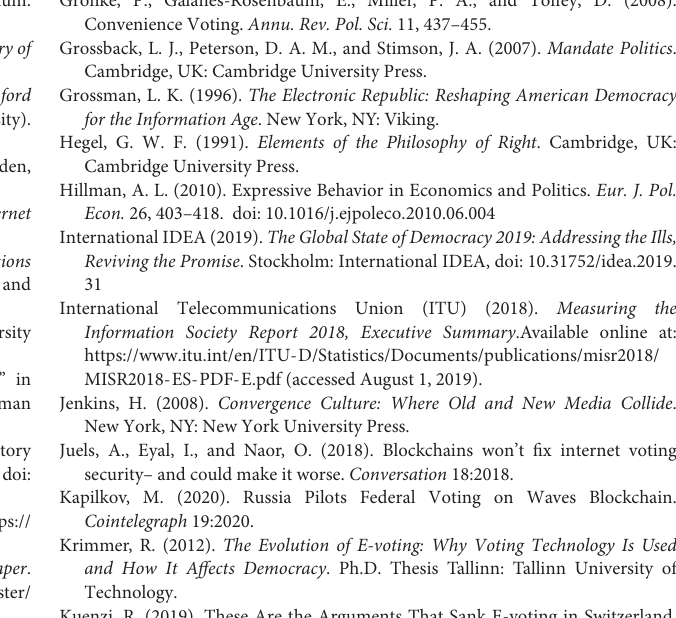
Cointelegraph 19:2020. Krimmer, R. (2012). The Evolution of E-voting: Why Voting Technology Is Used and How It Affects Democracy . Ph.D. Thesis Tallinn: Tallinn University of